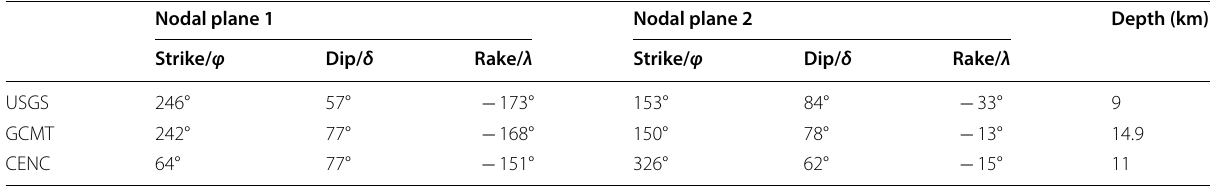
Table 1 Focal mechanism of the 2017 Jiuzhaigou earthquake Nodal plane